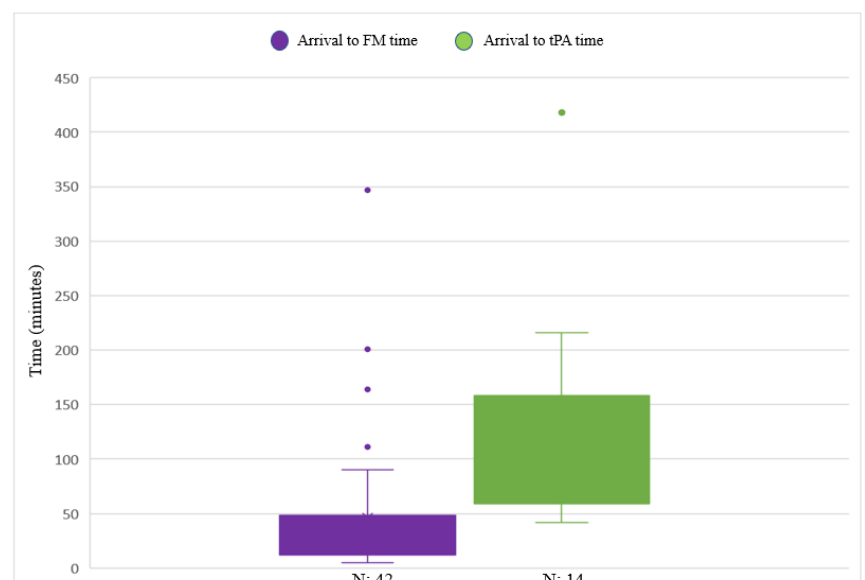
Figure 2. Time to fluorescence microangiography and time to tissue plasminogen activator from arrival in the emergency department. tPA, tissue plasminogen activator; FM, fluorescence